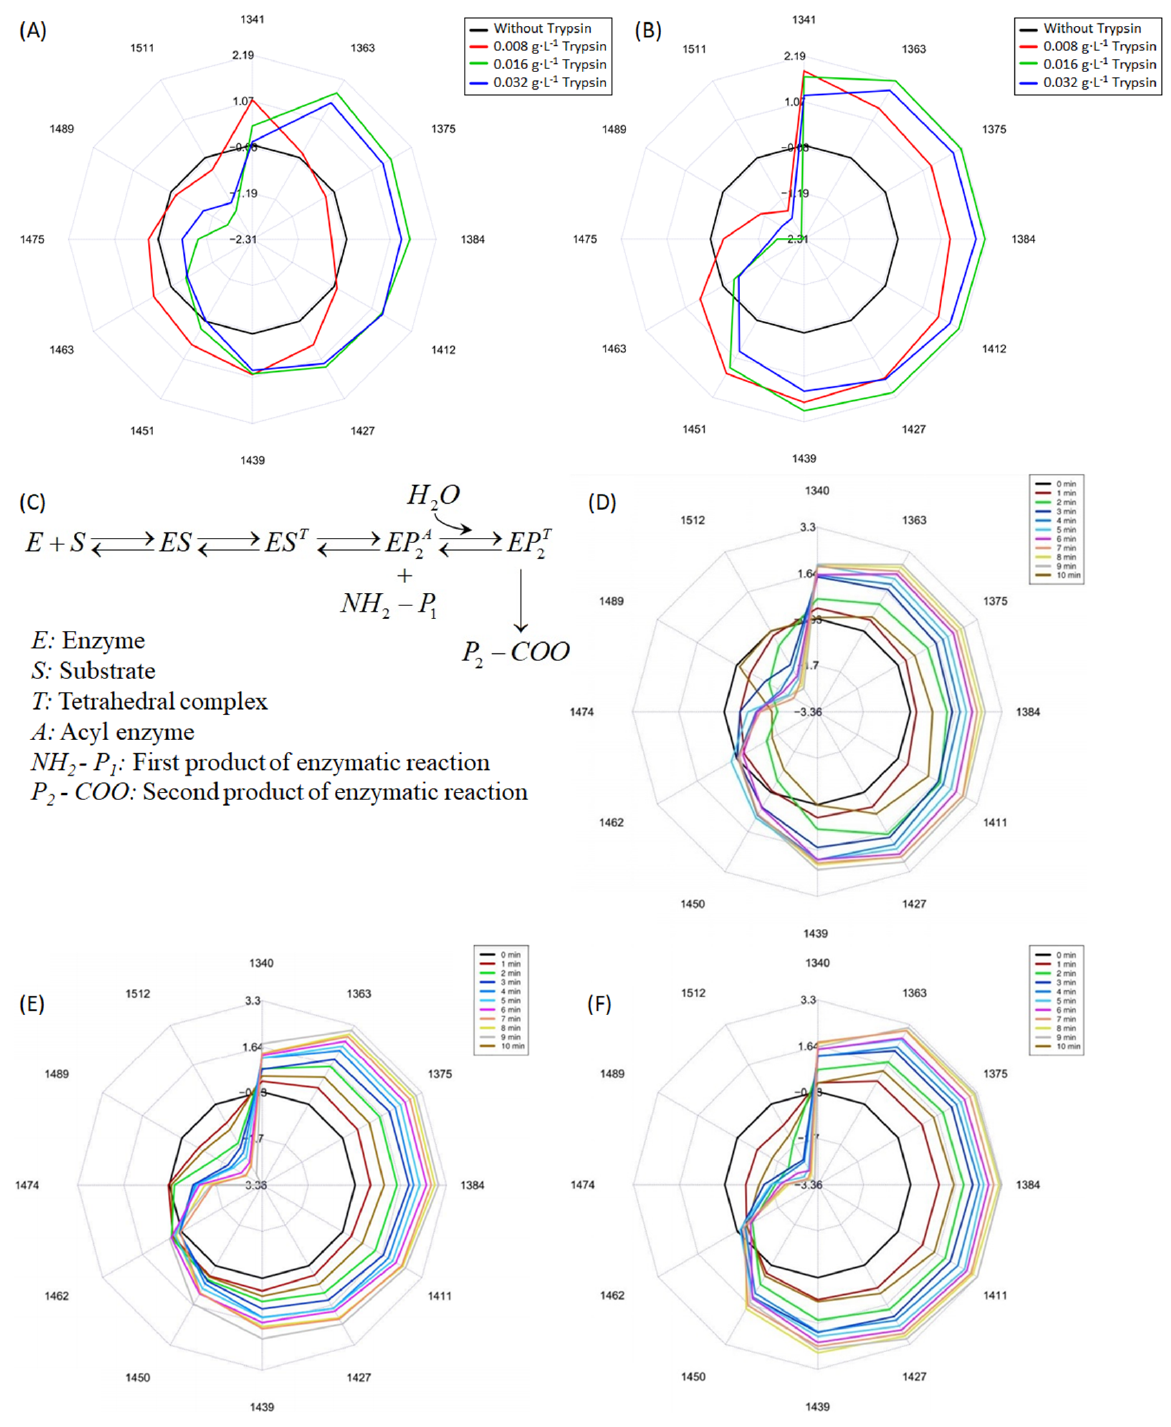
Figure 5. Aquagrams of the protein hydrolysis reaction with three different concentrations of trypsin at the start time ( A ) and after 10 min ( B ). Catalytic cycle of trypsin during protein hydrolysis ( C ). Aquagrams of the protein hydrolysis reaction by 0.008 g · L − 1 of trypsin ( D ), 0.016 g · L − 1 of trypsin ( E ), and 0.032 g · L − 1 of trypsin ( F